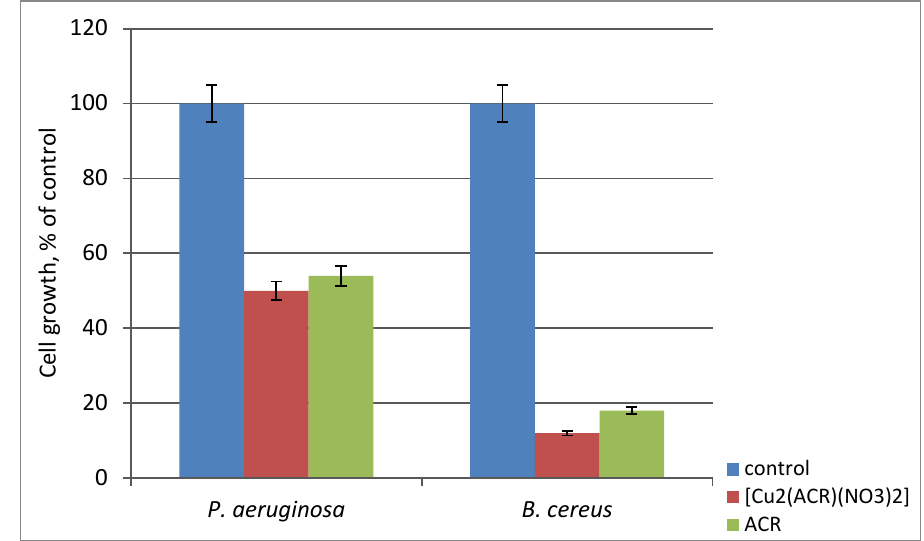
Figure 5. Reduction of the growth of model bacteria by untreated (control) and treated cotton fabrics.